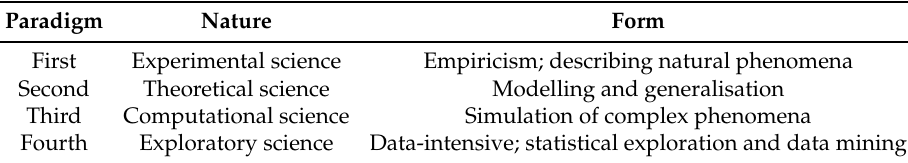
Table 1. The four paradigms of science. Adapted from [31].